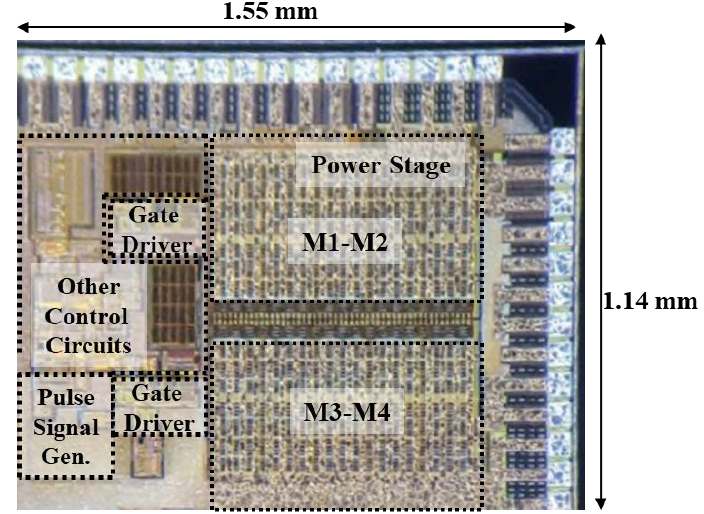
Figure 8. Microchip photograph of the proposed buck-boost DC–DC converter.